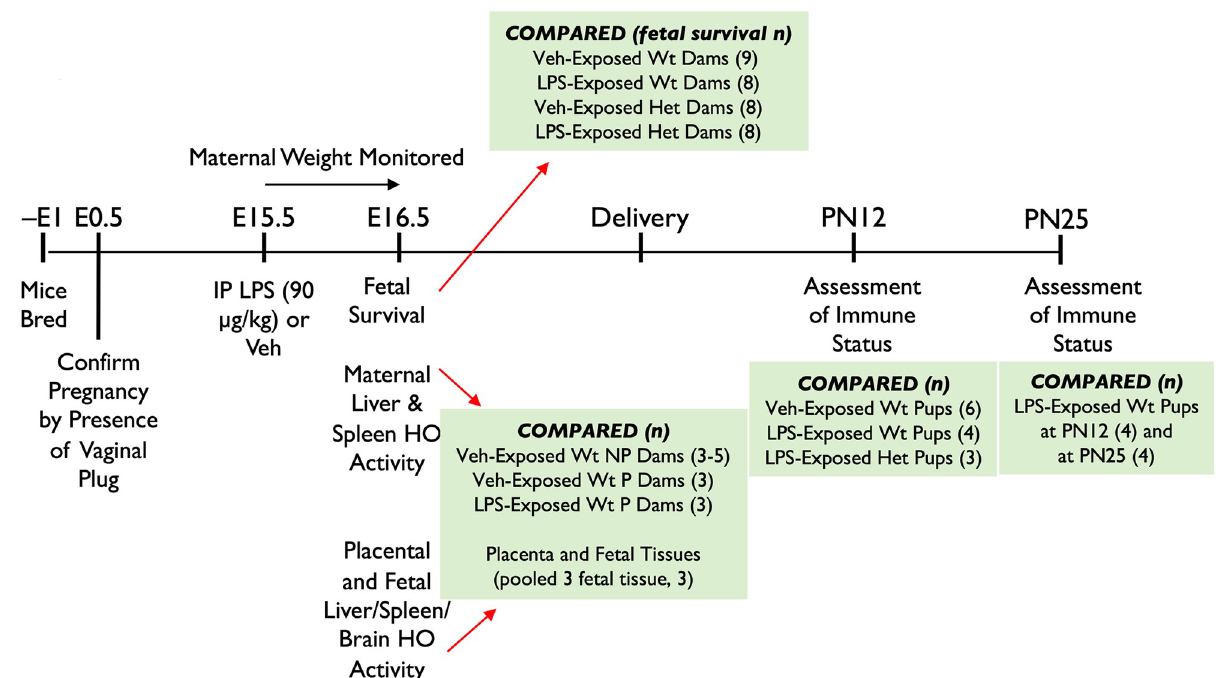
Fig 1. Late gestation inflammation model. LPS, lipopolysaccharide; NP, non-pregnant; Veh, vehicle; Wt, wild-type; Het, HO-1 heterozygote; PN, post-natal; i.p., intraperitoneal; HO, heme oxygenase; E, embryonic age.